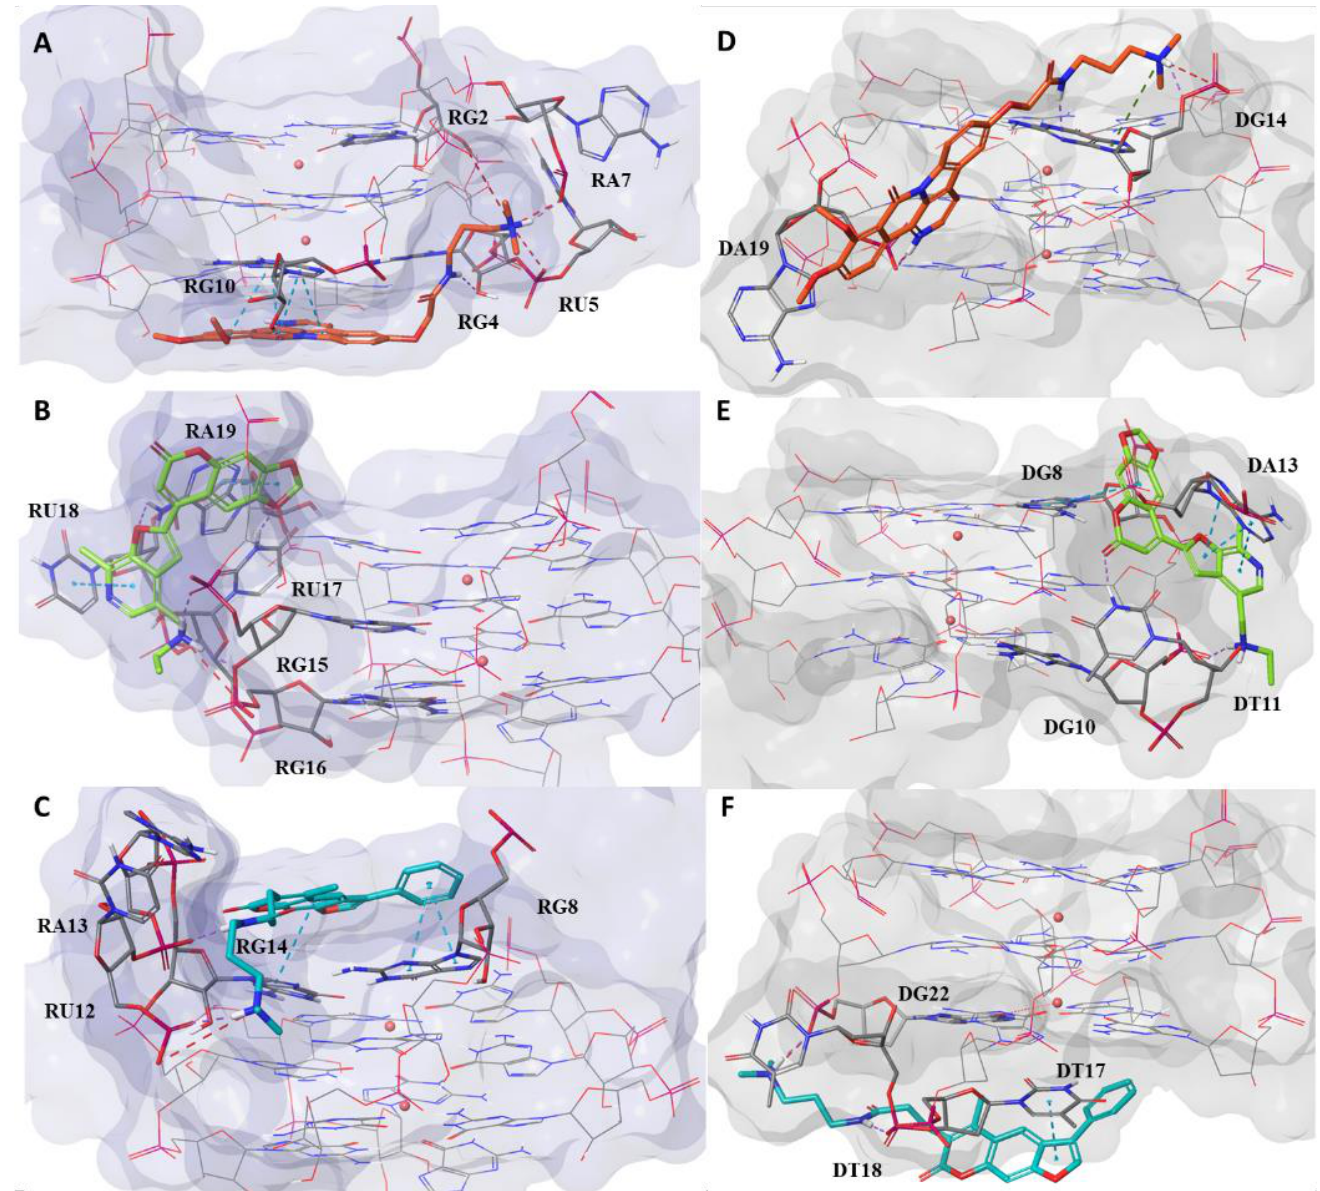
Figure 2. A docking pose analysis of the best thermodynamic complexes of hits 7 (panels ( A , D )), 15 (panels ( B , E )), and 17 (panels( C , F )) in complex with TERRA and Tel, respectively. For hits 7 , 15, and 17, the ligand is depicted as orange, green, and cyan carbon sticks, respectively. The nucleic acids are shown as faded blue and grey surfaces for TERRA and Tel, respectively, while the guanine residues, forming the G-tetrads, are shown as lines. Moreover, the residues interacting with the ligands are depicted as faded blue and grey carbon sticks for TERRA and Tel, respectively. K + ions are represented as pink spheres. Hydrogen bonds, salt bridges, and π–π and π– cation interactions are shown as dashed violet, red, cyan, and green lines, respectively.